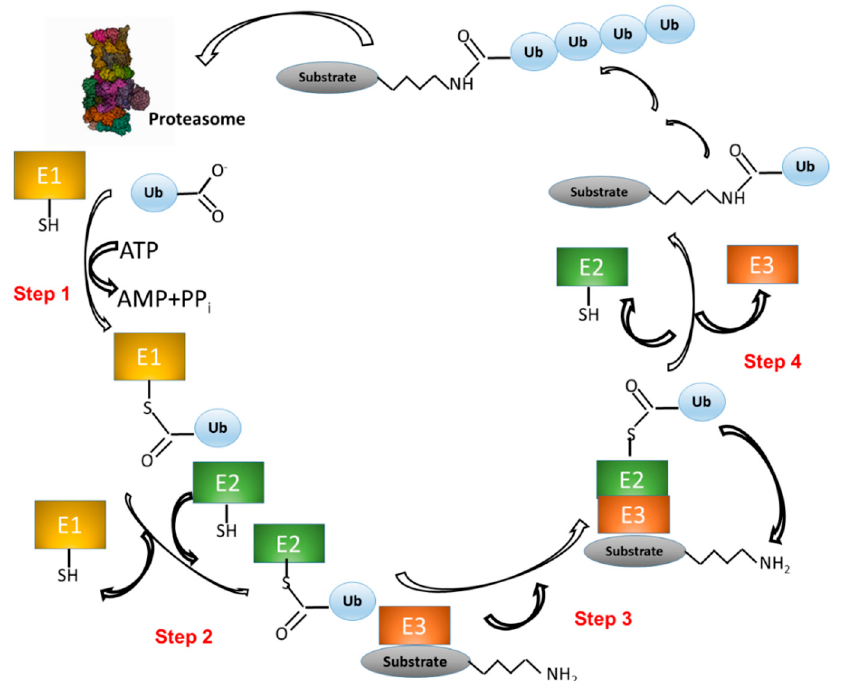
Figure 1. The ubiquitination pathway. (1) Ubiquitin (Ub) is linked to a cysteine residue of a Ub- activating enzyme (E1) via a reaction that uses the energy derived from the hydrolysis of an ATP molecule. (2) Ub is transferred from E1 to the cysteine of a Ub-conjugating enzyme (E2). (3) A complex is formed between E2–Ub and a Ub ligase (E3), which is able to bind a protein substrate. (4) Ub is transferred from E2 to a lysine residue of the protein substrate. Other Ub molecules can be added to the substrate–Ub complex with the same mechanism (steps 1–4). Finally, the polyubiquitinated substrate is recognized and degraded by the proteasome, whereas Ub is released and ready to start a new cycle.